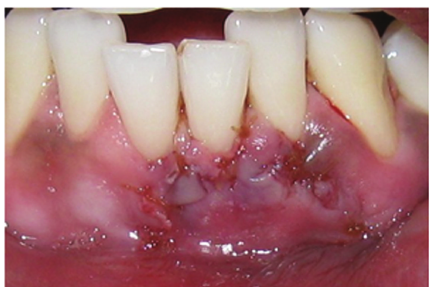
Figure 6: The graft was sutured by independent sling sutures and secured to the adjacent papillae by interrupted sutures in the reces- sion area. Graft covering the fenestration defect was secured to the adjacent flap with interrupted sutures.